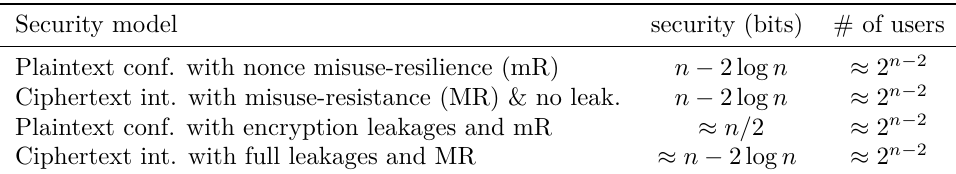
Table 3: Multi-user security